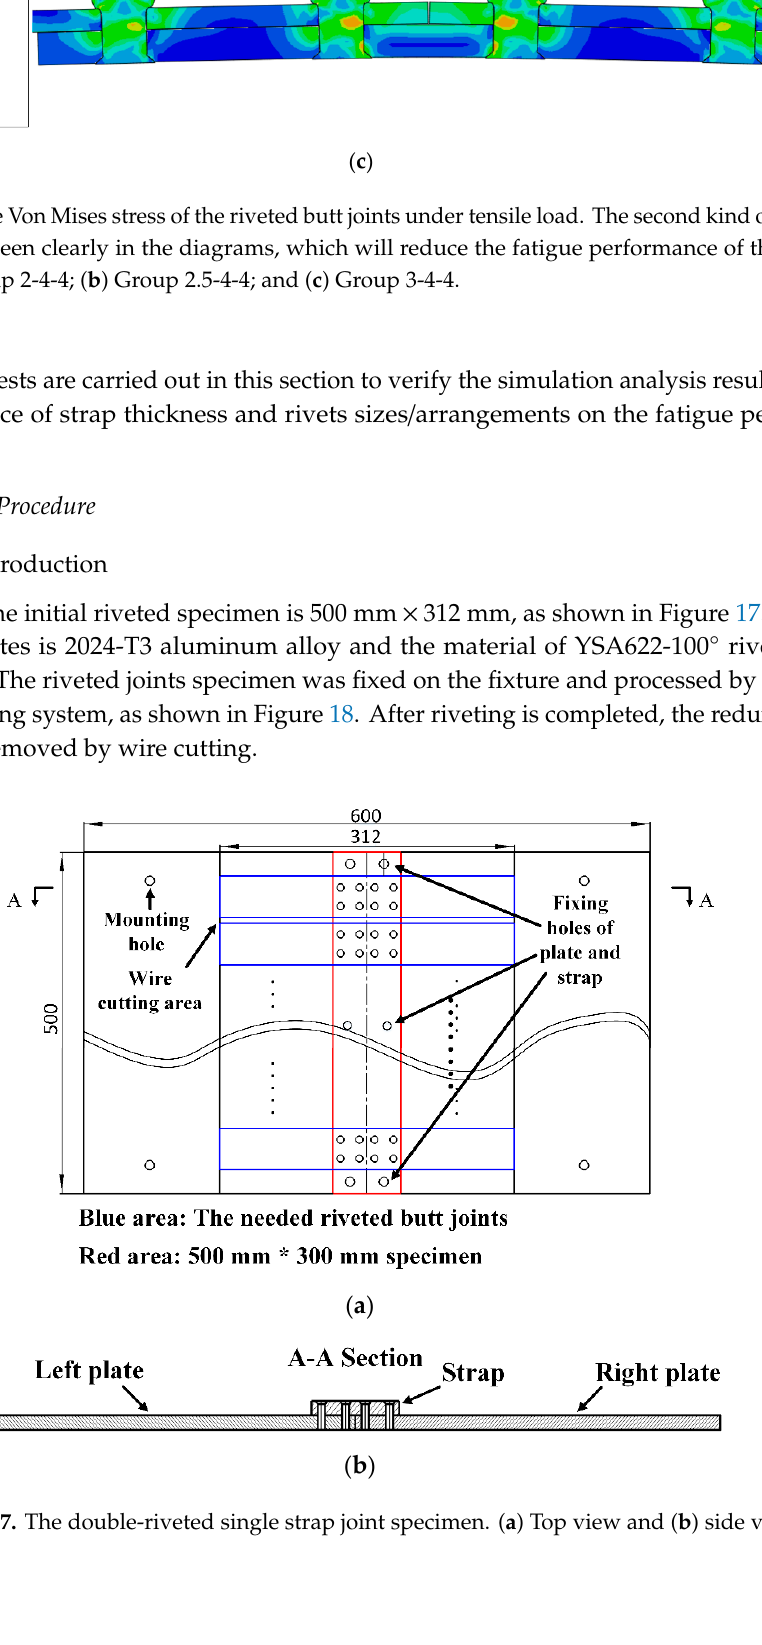
Figure 17. The double-riveted single strap joint specimen. ( a ) Top view and ( b ) side view.